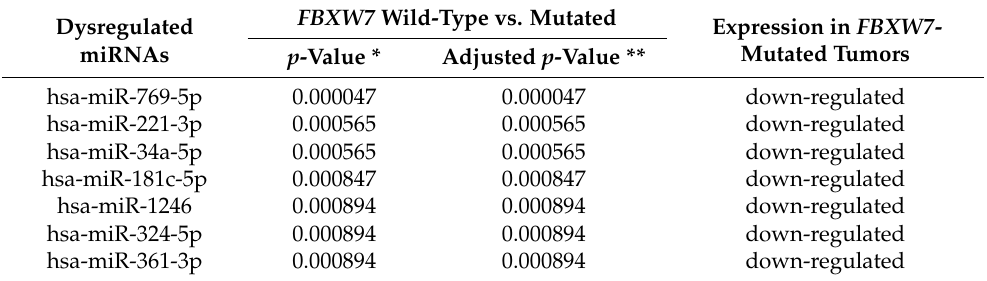
Table 2. miRNA expression profiles between FBXW7 -wild-type and -mutated rectal neuroendocrine tumors.